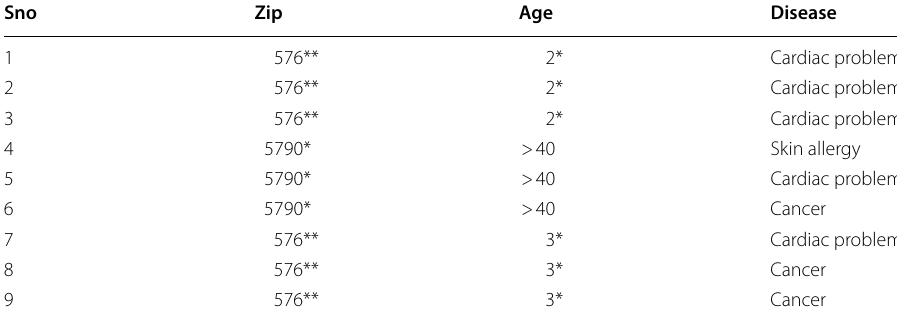
Table 2 After applying anonymization on Zip and age Sno